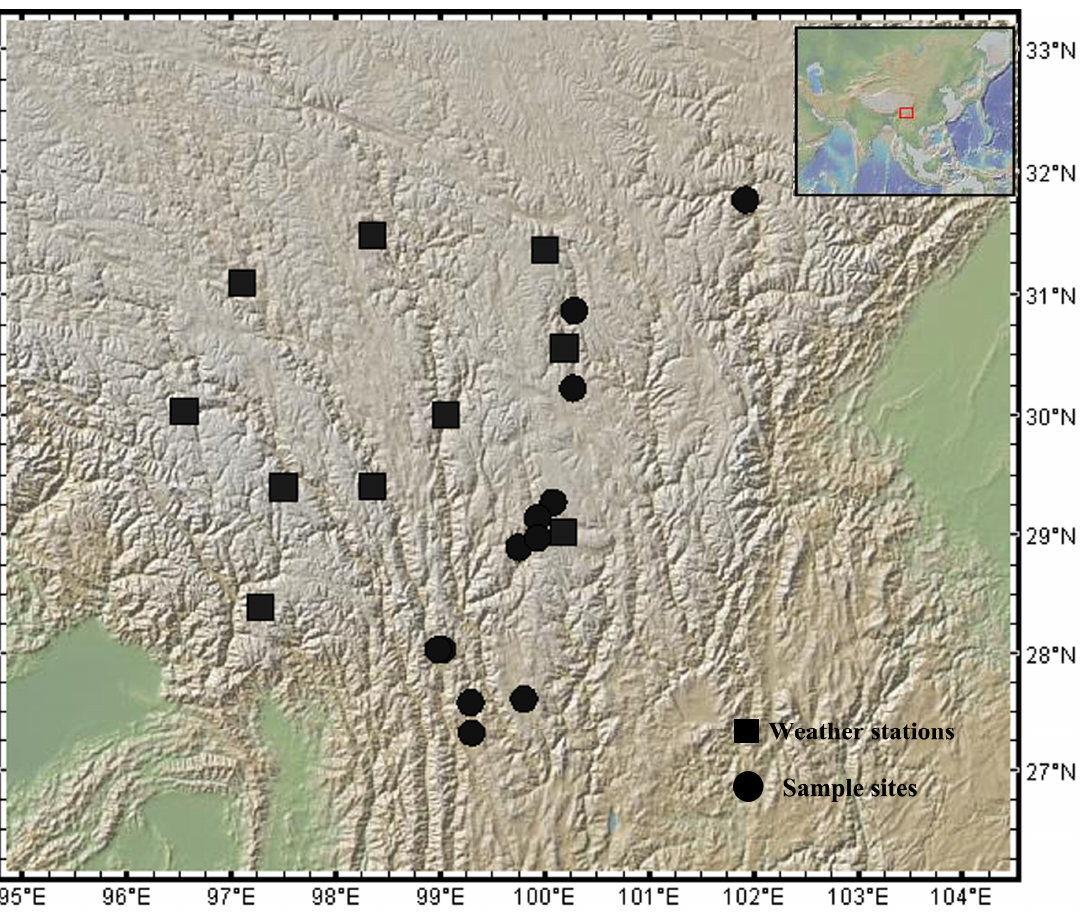
Figure 1. Locations of tree ‐ ring sample sites and weather stations.